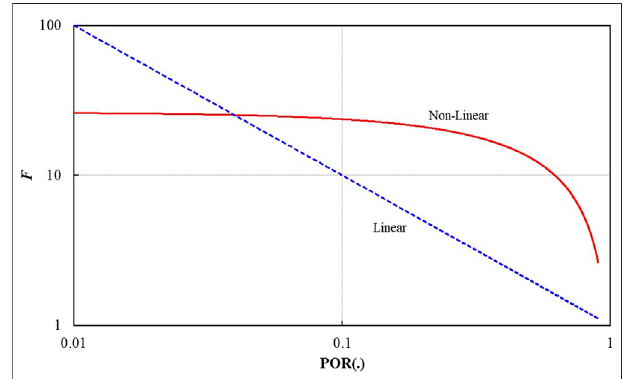
FIGURE 2 | The nonlinear and linear relationship in Eqs 10 , 11